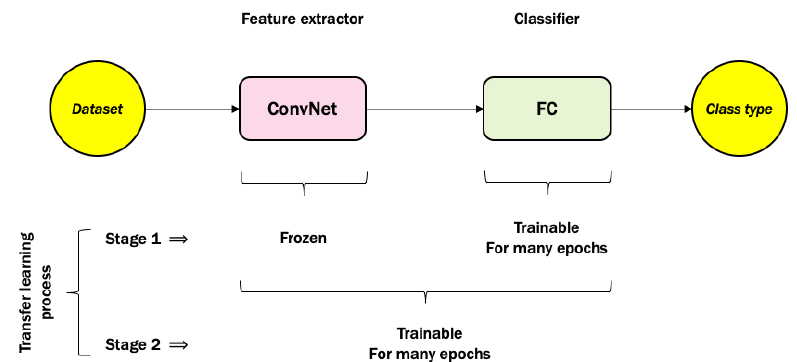
Figure 4. The concept of transfer learning of convolutional neural networks (CNN). ConvNet: any pre-trained convolutional network and FC: fully connected network.